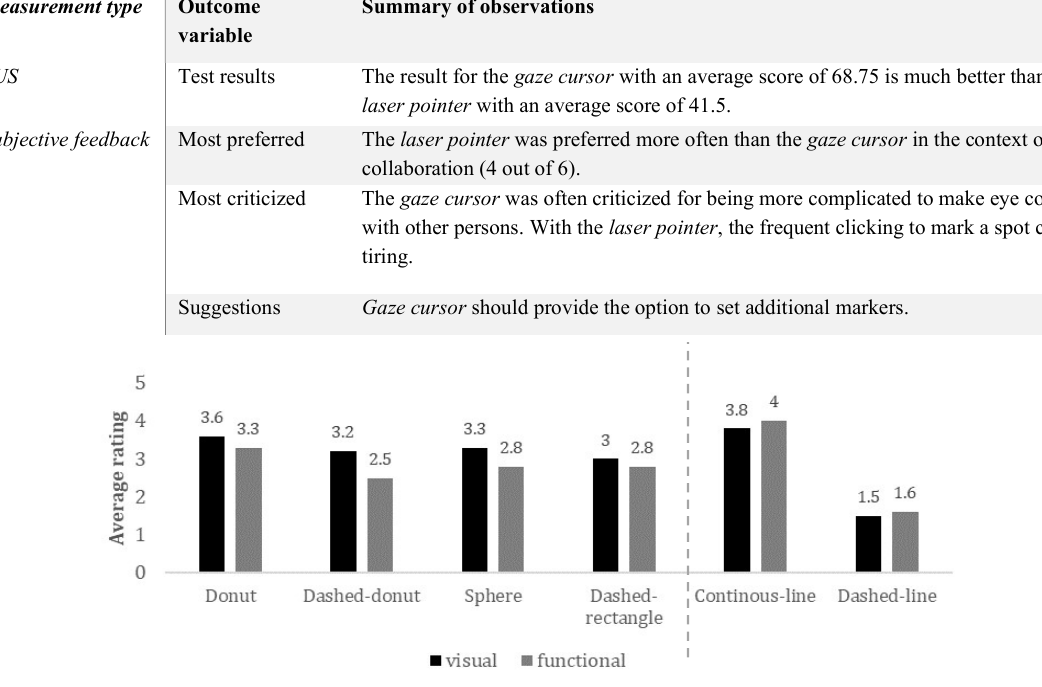
Figure 8. Participants’ average ratings (1 “very bad” to 5 “very good”) for the six visualization design options. First four are the point-of- regard visualizations of gaze, whereas the last two are visualizations of the gaze line. Participants rate the continuous donut-cursor best among the point of regard visualization options, and they rate continuous-line clearly higher than the dashed line for the gaze line visualization